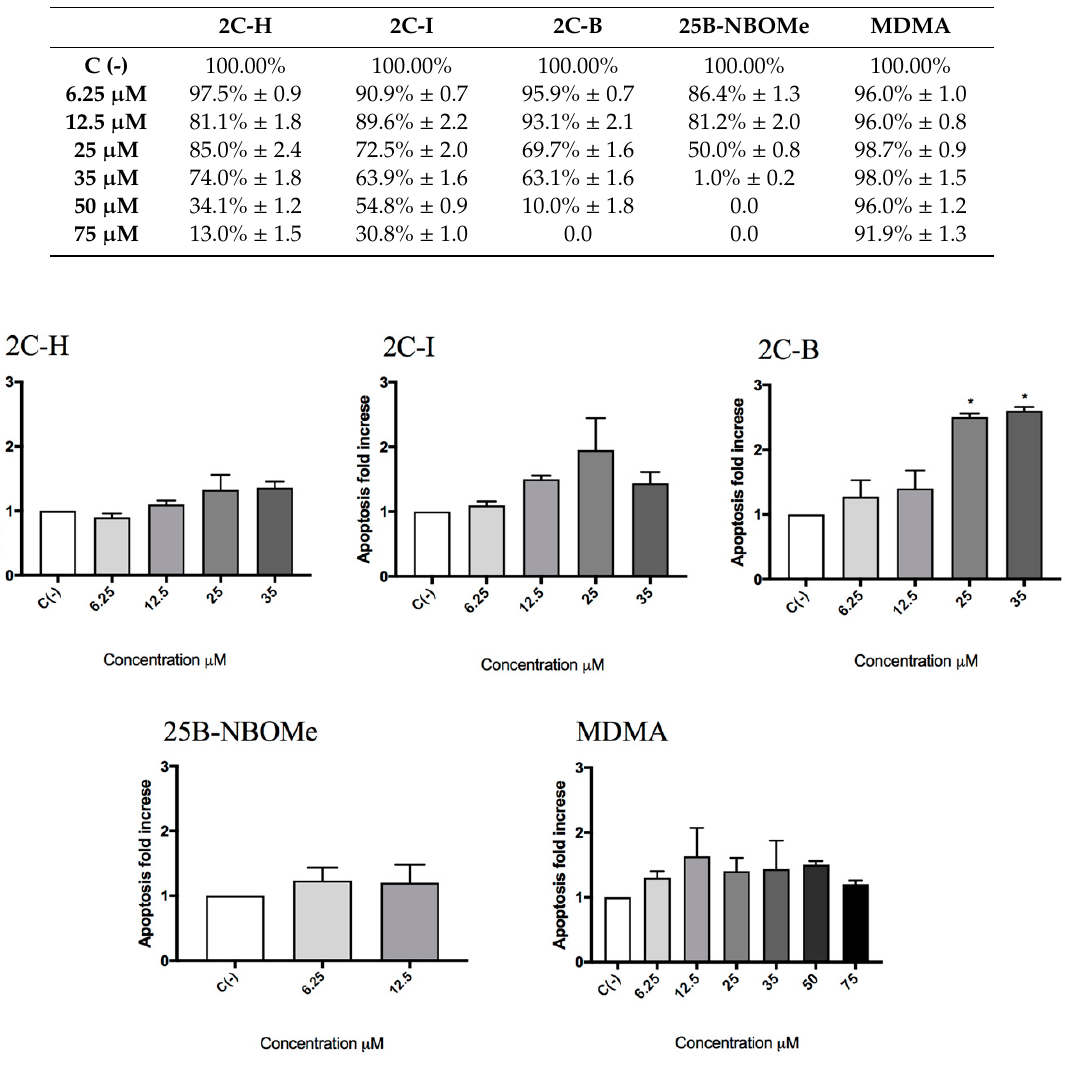
Figure 3. The apoptosis fold increase on TK6 cells after 26 h of treatment with 2C-H, 2C-I, 2C-B, 25B-NBOMe, and MDMA at the indicated concentrations with respect to the untreated control C (-). Each bar represents the mean ± SEM of five independent experiments. Data were analysed using repeated ANOVA followed by Bonferroni or Dunnet post-tests. * p < 0.05 versus C (-).